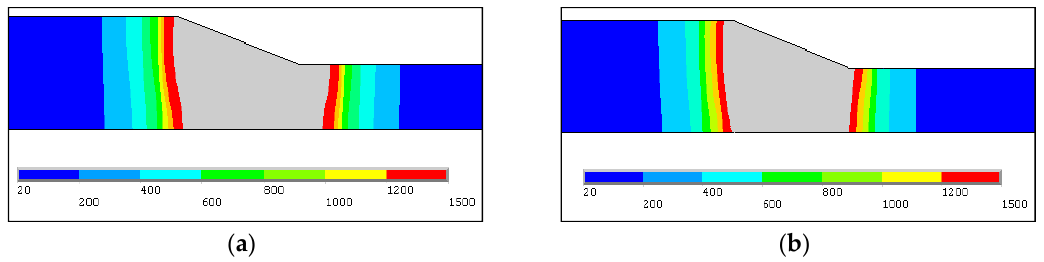
Figure 9. The calculated weld cross-section of tailored blanks cross-section (Arrangement mode I, 1800 W total power, and 1.2 m/min welding speed): ( a ) 1:1 power ratio; ( b ) 2:1 power ratio.